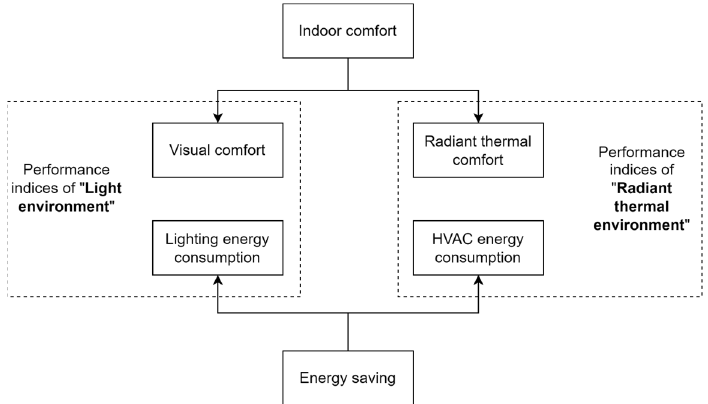
Figure 4. Performance indices of a shading operation.